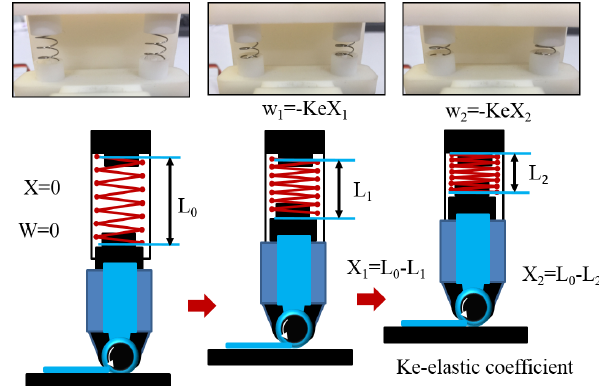
Figure 6. The control principle of writing